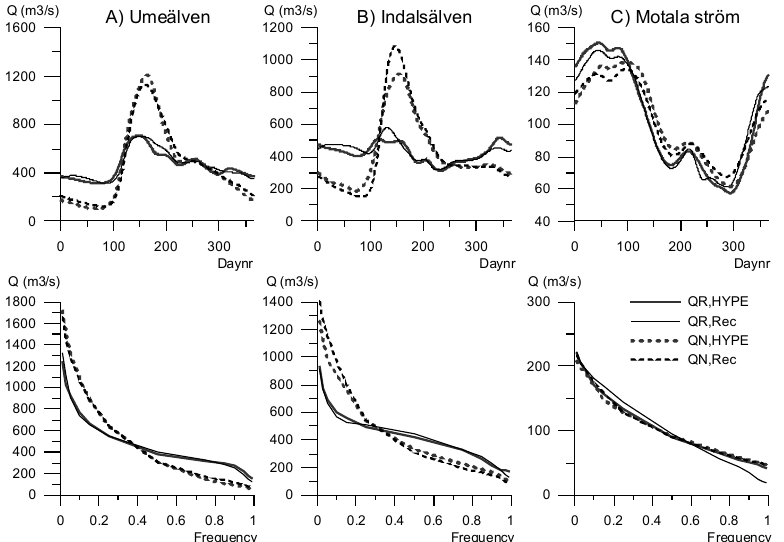
Fig. 4 River flow during regulated (QR, solid lines) and naturalized (QN, dotted lines) conditions at three hydropower plants across Sweden (cf. Fig 1), using the S-HYPE model and independent reconstructions, respectively. On top: Average daily water discharge during a general year. Bottom: Flow duration